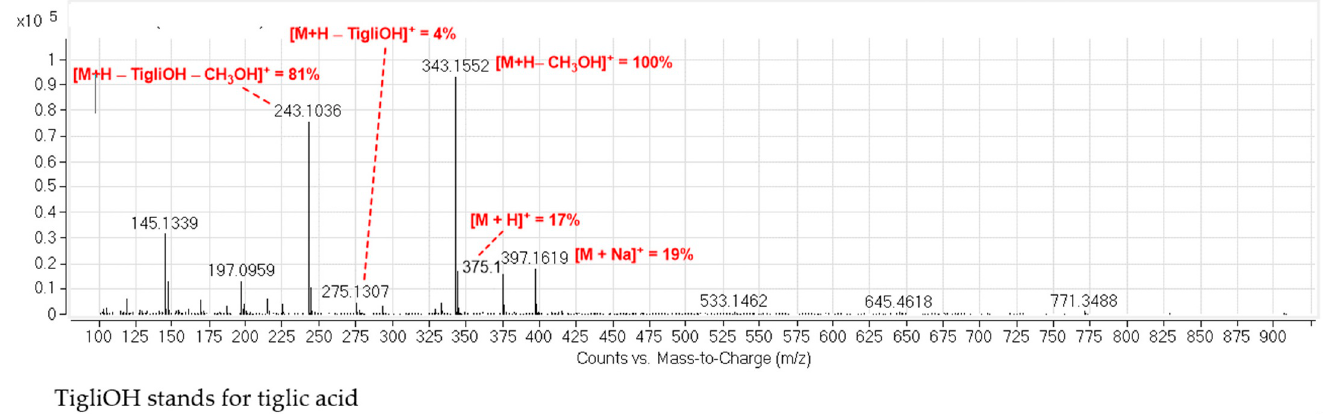
Figure 4. ESI-ToF-MS of peak IV.